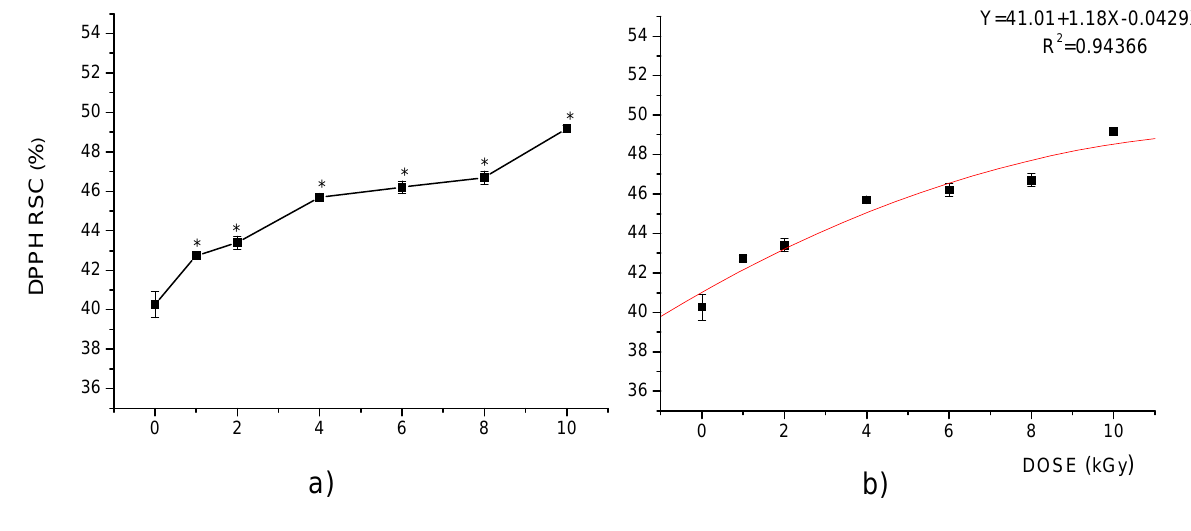
Figure 5. Effect γ -irradiation on DPPH Radical Scavenger Capacity (DPPH RSC) of soybean seeds (a) and polynomial curve fit (b). Each data point represents the mean ± SD; * ANOVA; Tukey-test, p <